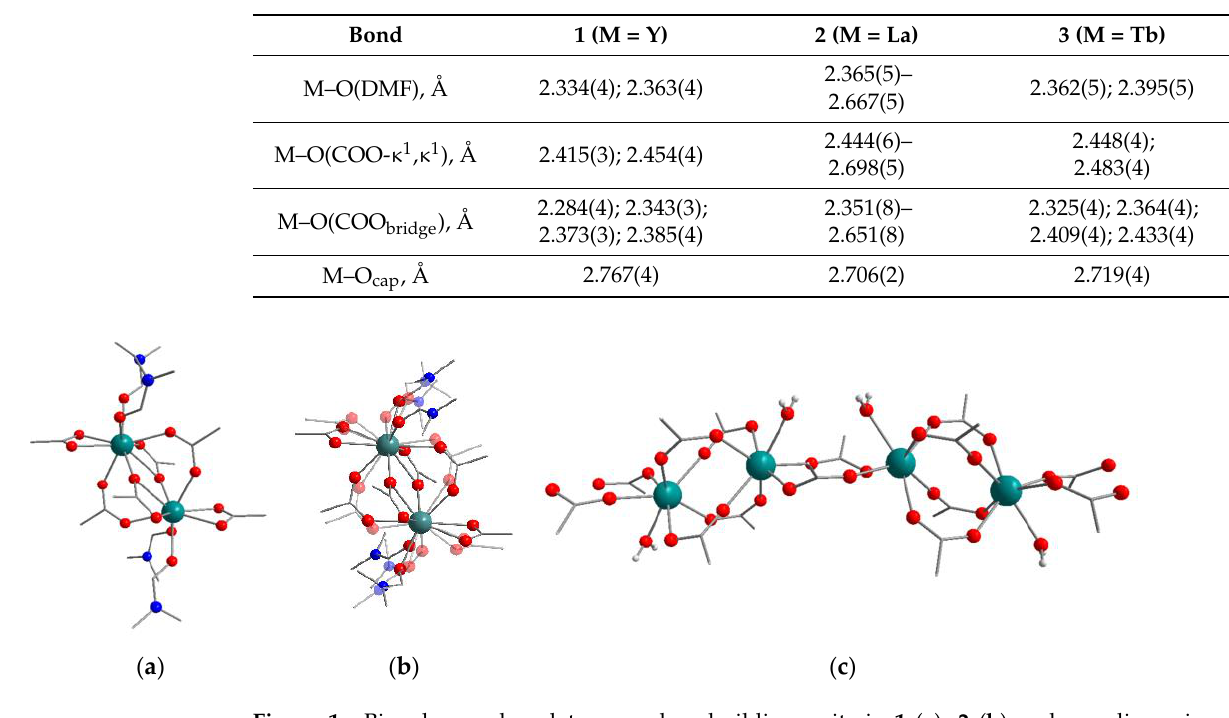
Figure 1. Binuclear carboxylate secondary building units in 1 ( a ), 2 ( b ) and one-dimensional lutetium(III)-carboxylate chains in 4 ( c ). Metal atoms are turquoise, N atoms are blue, O atoms are red. H atoms (grey) are shown only in H 2 O ligands. Table 1. Selected bond lengths in the structures 1 – 3 .